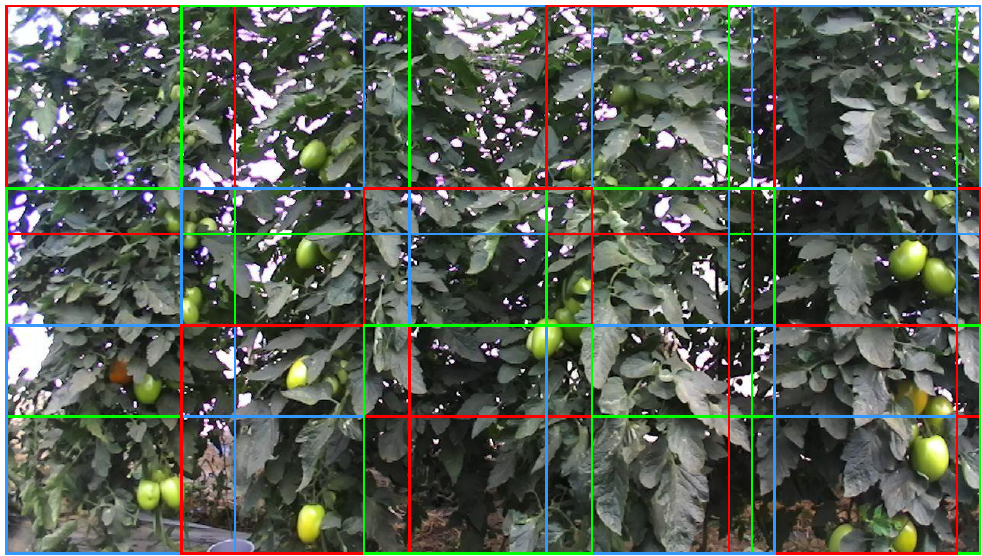
Figure 7. Images split into 300 × 300 px images with an overlapping ratio of 20%. The different colours are only for reference and distinguishing the different